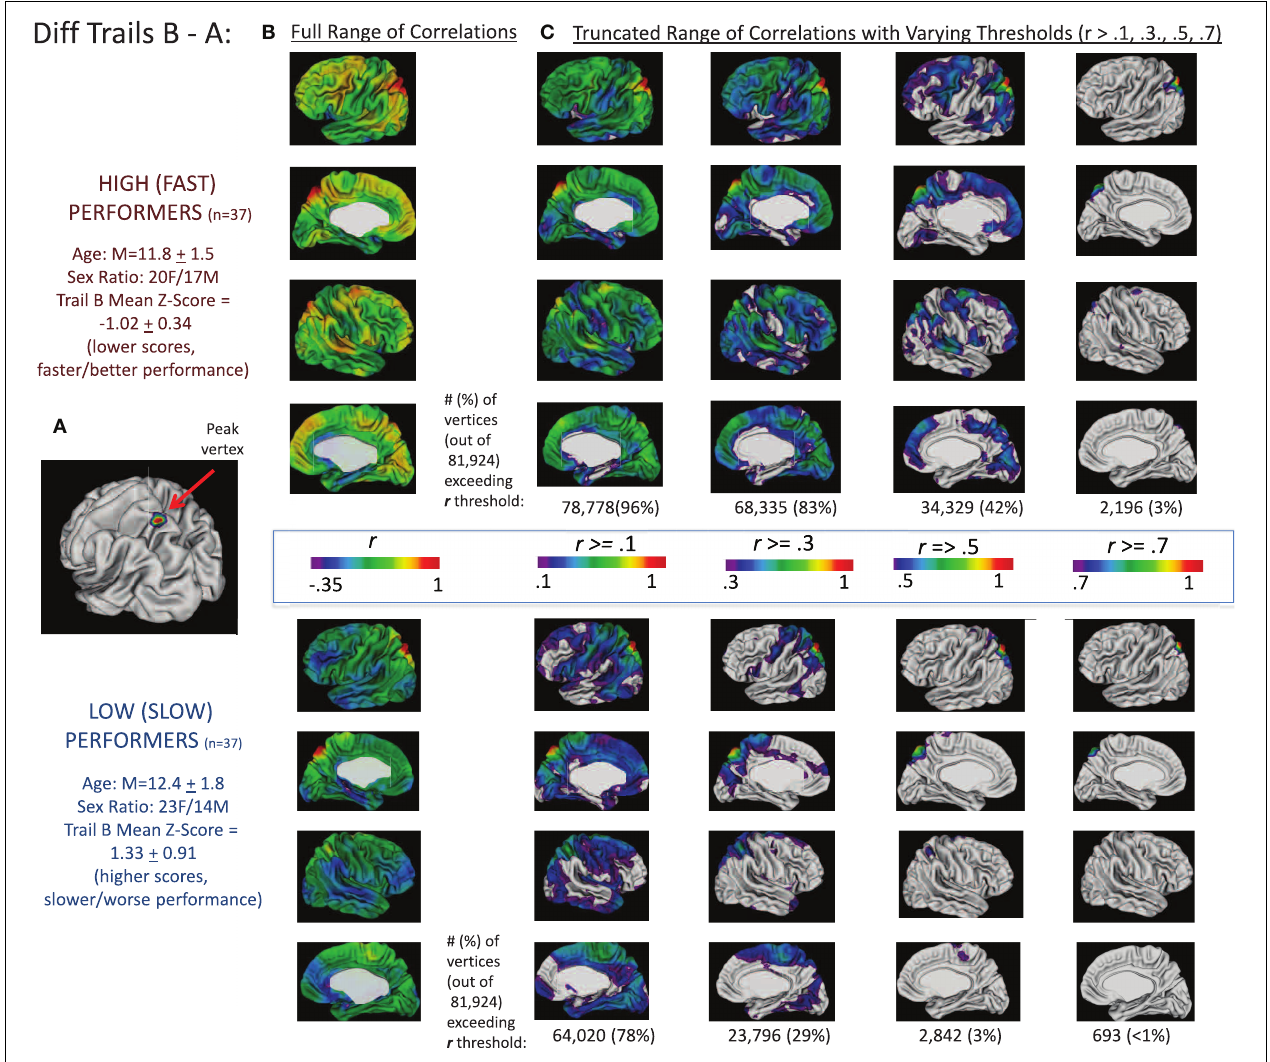
FIGURE 3 | Correlations between peak vertex thickness in the superior parietal lobule and the rest of the cortex in high ( n = 37) and low ( n = 37) performers on the Trails B–A difference score. Analogous to the procedures described in Figure 2 , the complete sample of 146 participants was divided into quartiles based on performance on the difference in Trails B and A times (age-adjusted scores). We then ran two sets of correlations between the thickness of the peak vertex identified in prior analyses in superior parietal lobule [shown in (A) ; MNI coordinates: x = − 22, y = − 68, z = 62] and all vertices in the left and right hemisphere for the group of high/fast performers (those with scores in the lower quartile—denoting faster